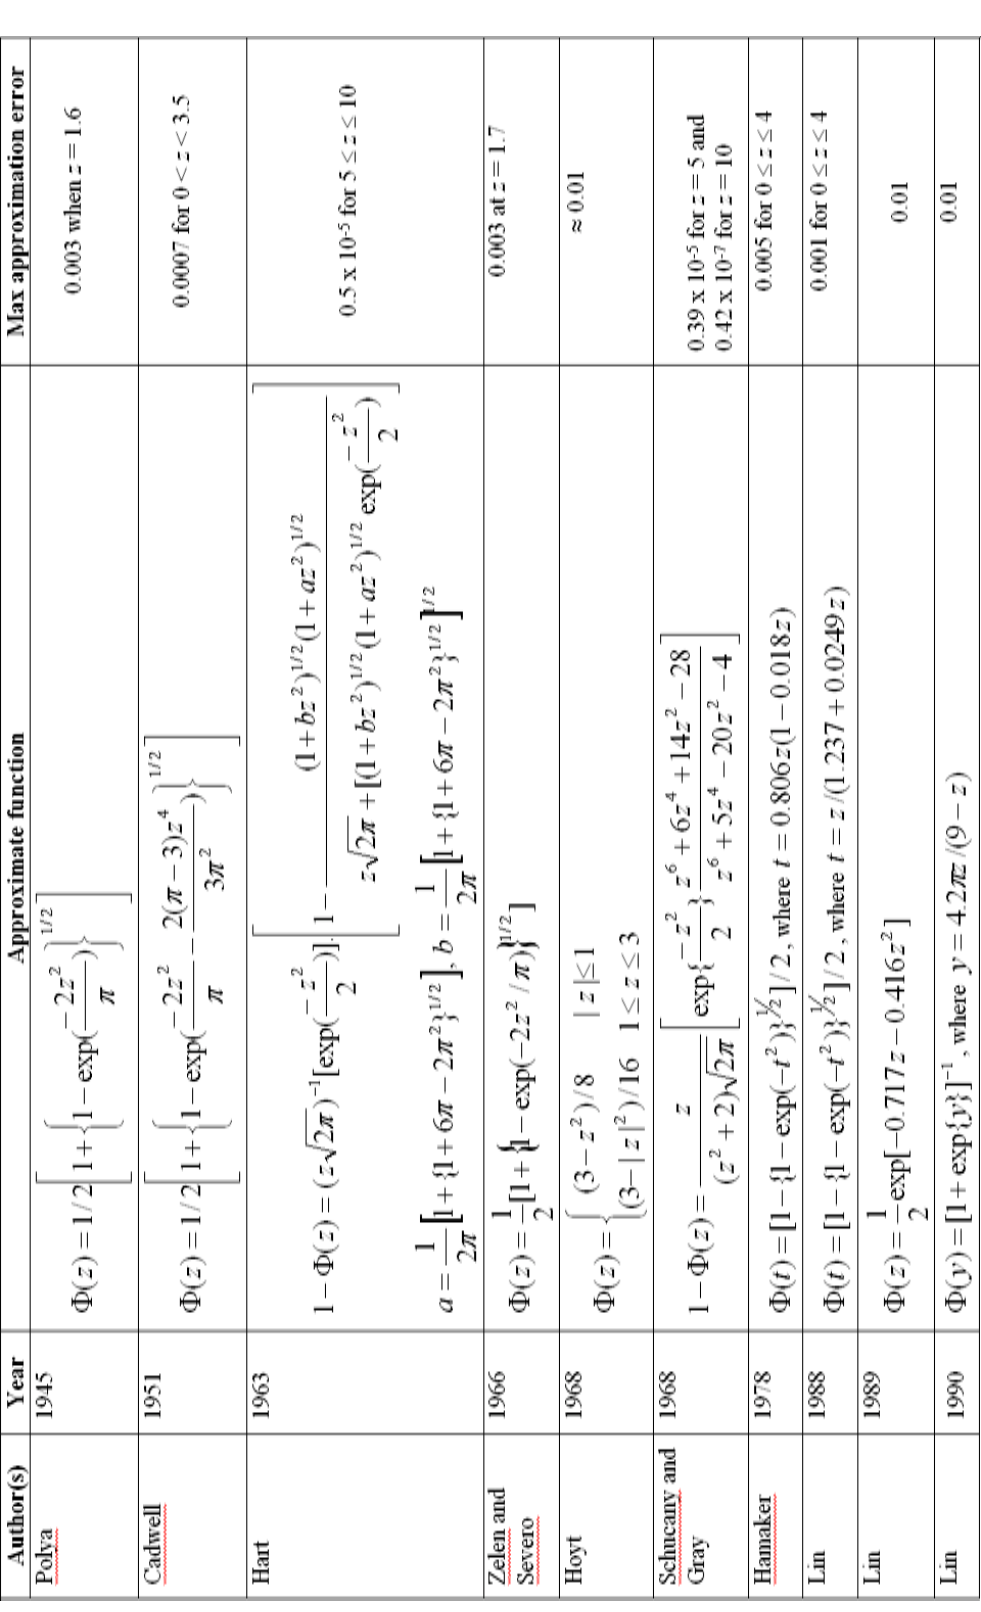
Table 1. “A summary of approximate functions of the cumulative normal